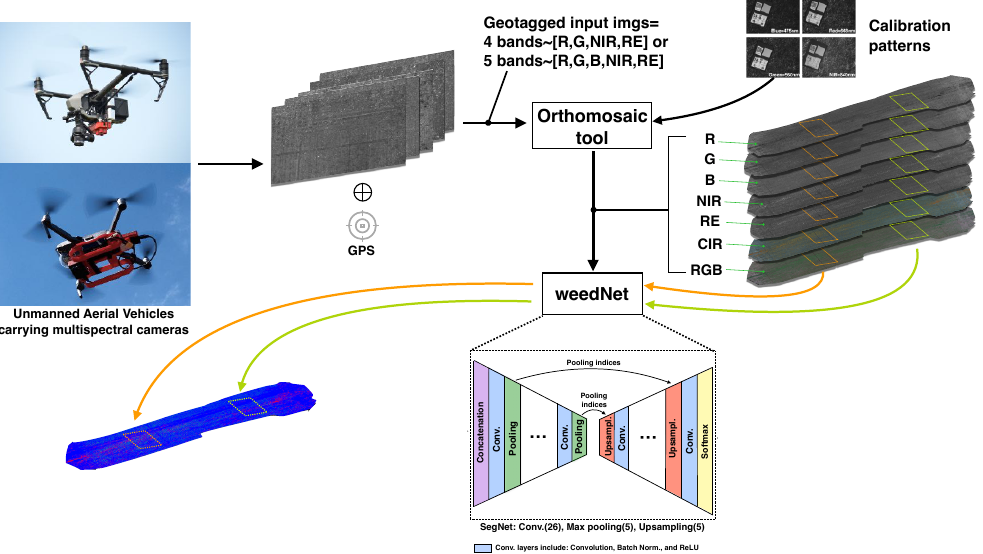
Figure 8. Our overall processing pipeline. GPS tagged multispectral images are first collected by multiple UAVs and then passed to an orthomosaic tool with images for radiometric calibration. Multi-channel and aligned orthomosaic images are then tiled into a small portion (480 × 360 pixels, as indicated by the orange and green boxes) for subsequent segmentation with a DNN. This operation is repeated in a sliding window manner until the entire orthomosaic map is